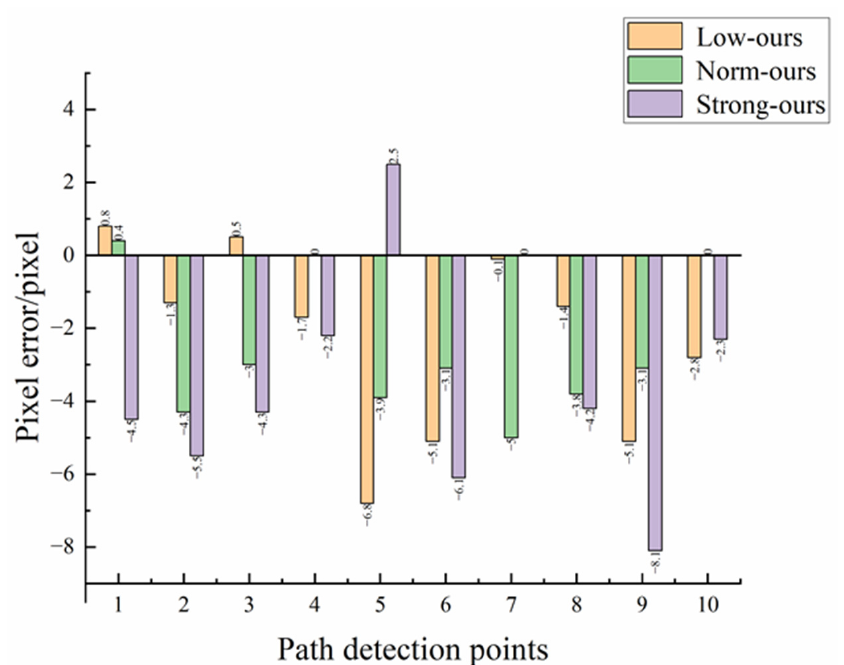
Figure 11. Pixel error comparison. Table 4. The error values of our model.